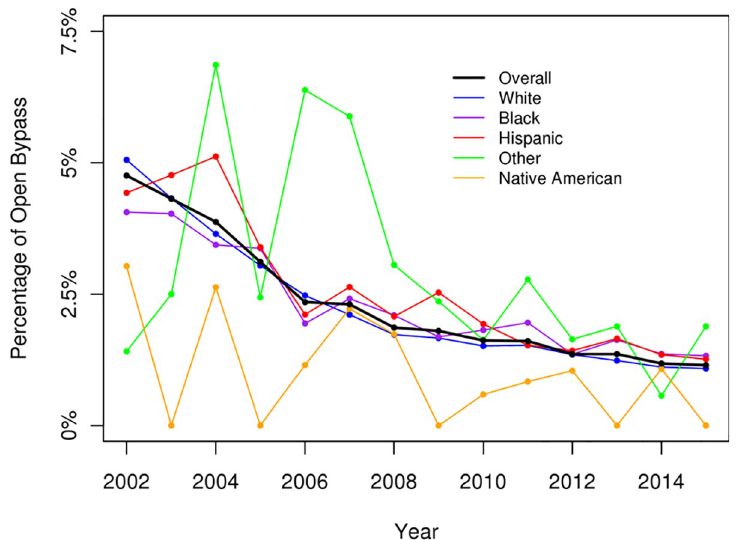
Fig 5. Open bypass for diabetic foot infection (overall p < .05).